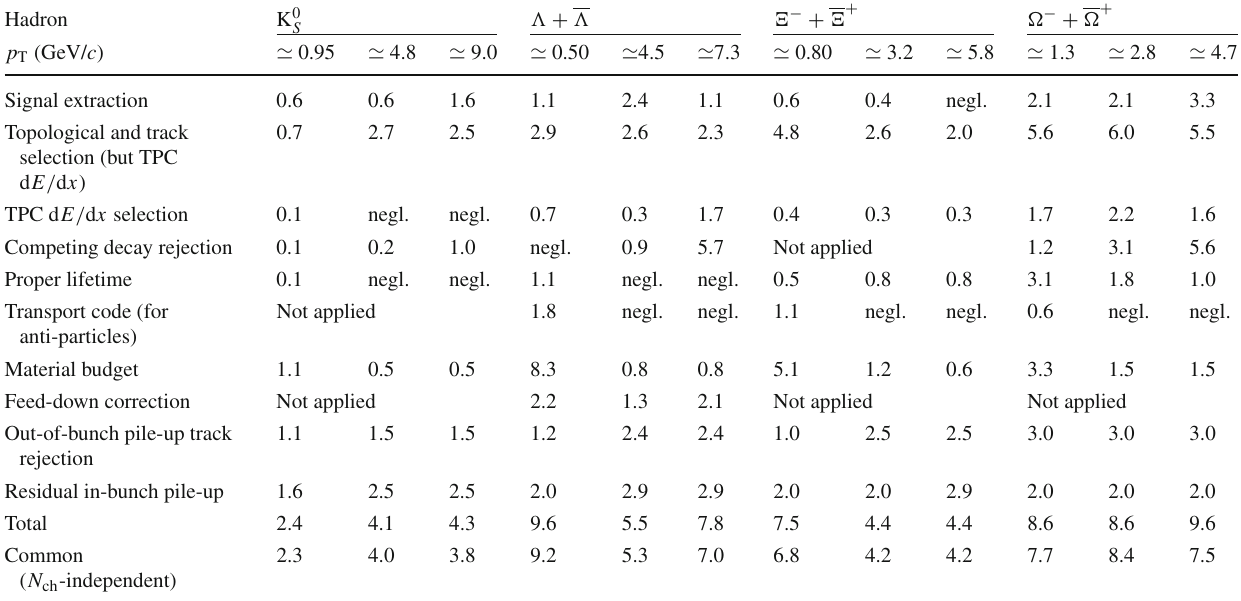
Table 4 Main sources and values of the relative systematic uncertain- ties (expressed in %) of the p T -differential yields. These values are reportedforlow,intermediateandhigh p T .ThevaluesfortheINEL > 0 data sample are shown in the table. Results as a function of multiplicity